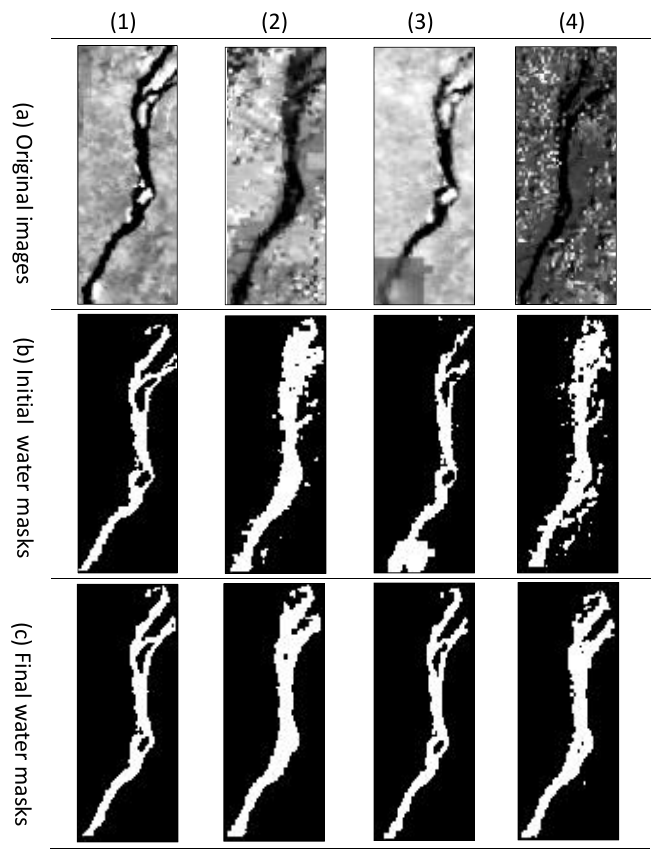
Figure 14. Four examples of generated water masks in different situations. ( a ) Original imaages; ( b ) Initial water masks; ( c ) Final water masks; (1,2) relate to the dry and wet seasons. In (3,4) images suffer from cloud